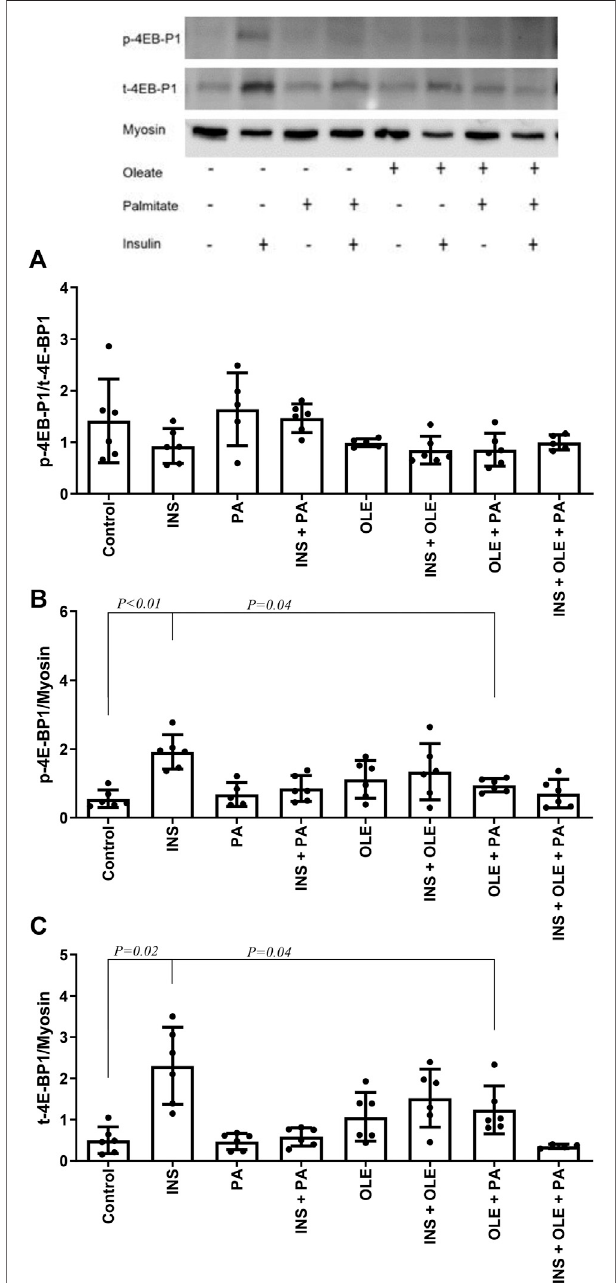
FIGURE 3 | Western blot analysis of p-4E-BP1/t-4E-BP1 (A) , p-4E- BP1 (B) and t-4E-BP1 (C) in differentiated C2C12 myotubes treated with either insulin (INS; 20 nM), palmitate (PA; 300 uM), oleate (OLE; 300 uM), or their combinations, and compared with the no treatment condition (i.e., control). Individual data points are depicted along with mean ± SD.